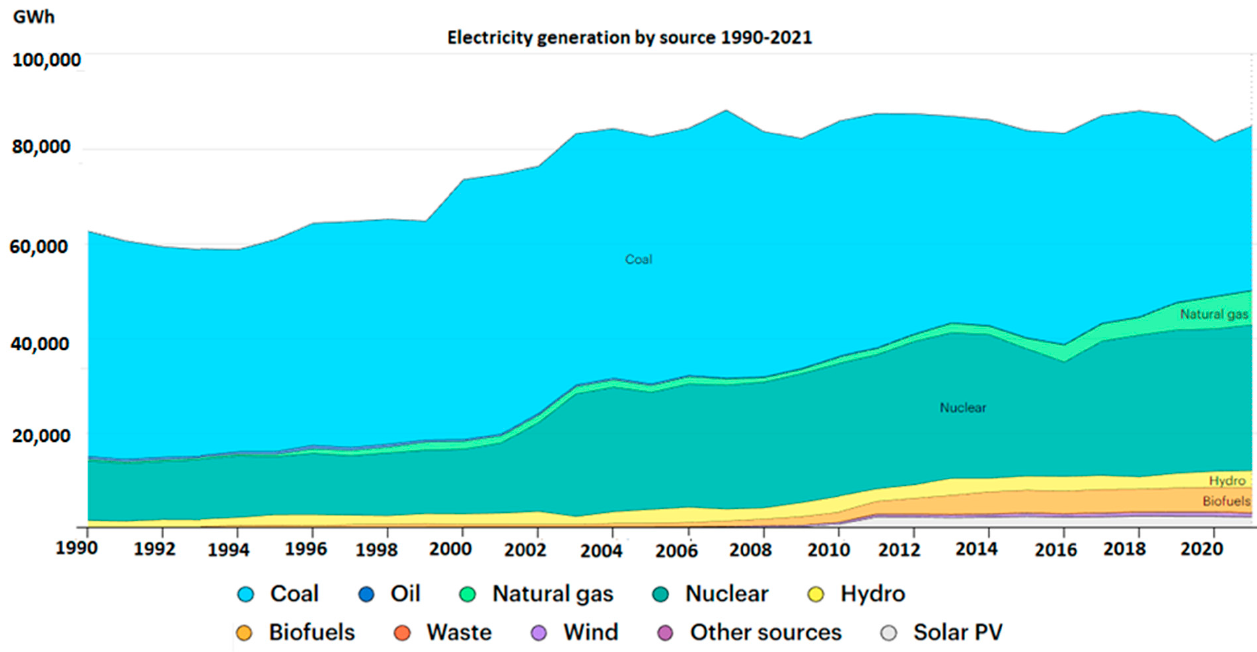
Figure 2. Energy production in the Czech Republic.